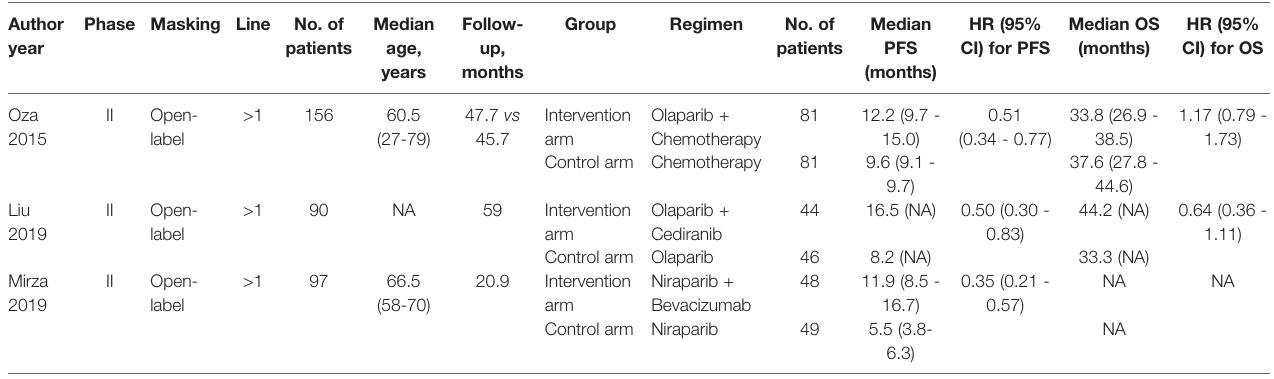
TABLE 1 | Characteristics of studies included in this meta-analysis.